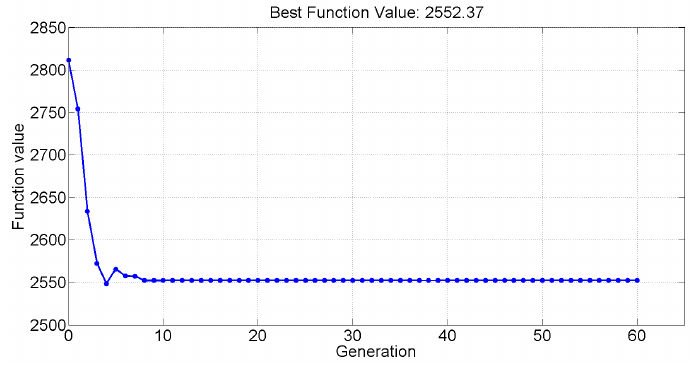
Table 4. Vehicle performance requirements.